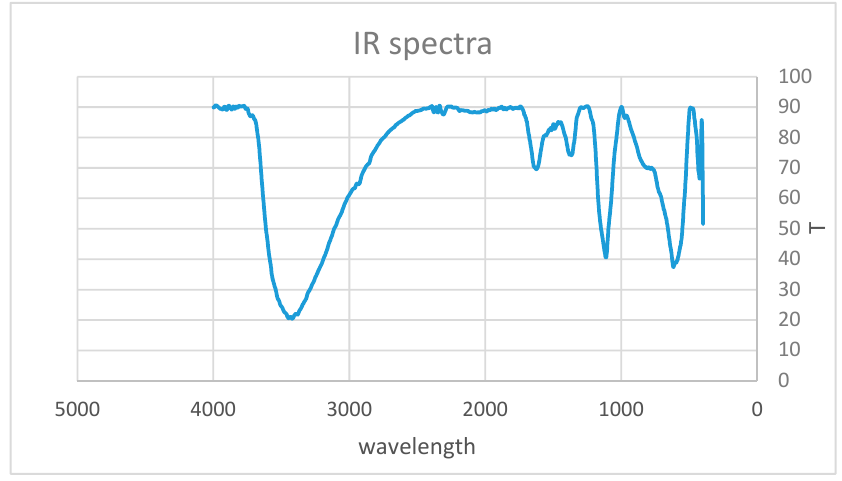
Figure 2. FTIR spectrum of Fe@Co-Al